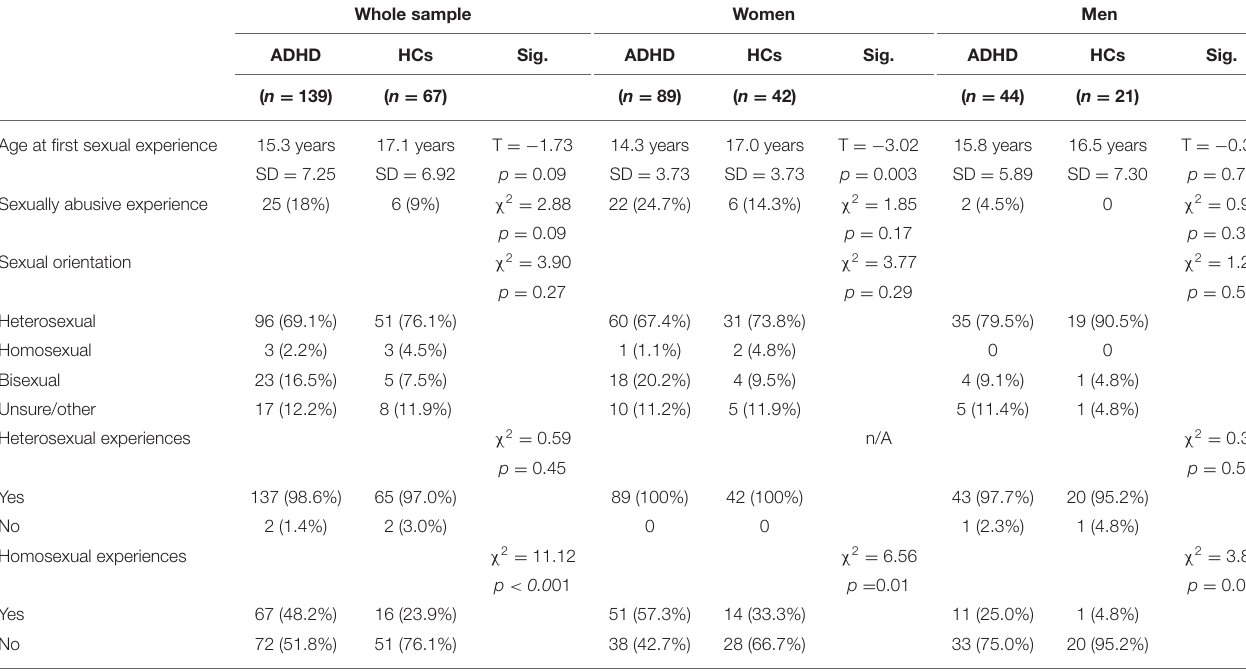
TABLE 2 | Sexual orientation and sexual experiences in individuals with and without ADHD. Whole sample Women Men ADHD HCs Sig. Sig.